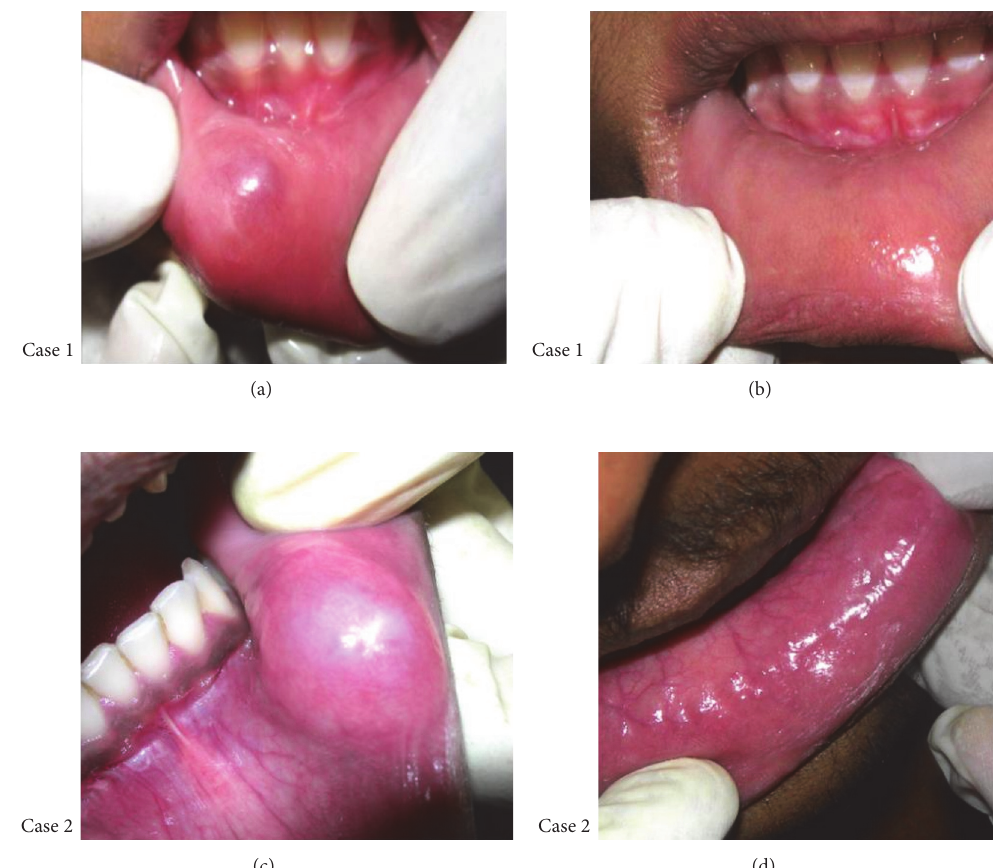
Figure 2: Case 1 showing mucocele in right lower labial mucosa measuring 5 ∗ 5 mm in size (a), complete regression of lesion after 2 intralesional injections (b), Case 2 showing large mucocele in left lower labial mucosa measuring 20 ∗ 15 mm in size (c), and complete regression of lesion after 4 intralesional injections (d).